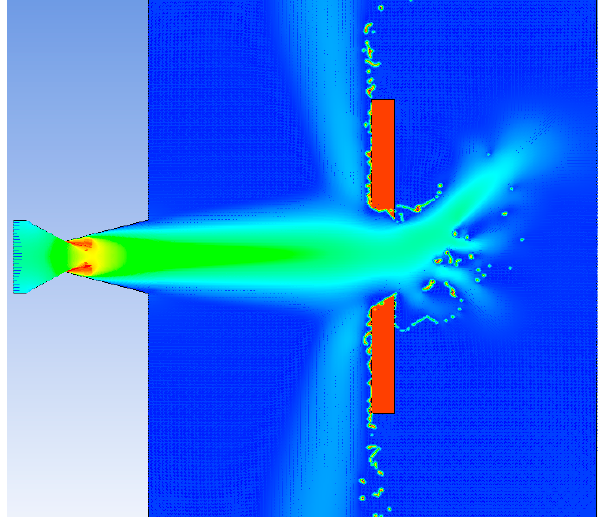
Figure 14. The velocity distribution at the moment of perforation.